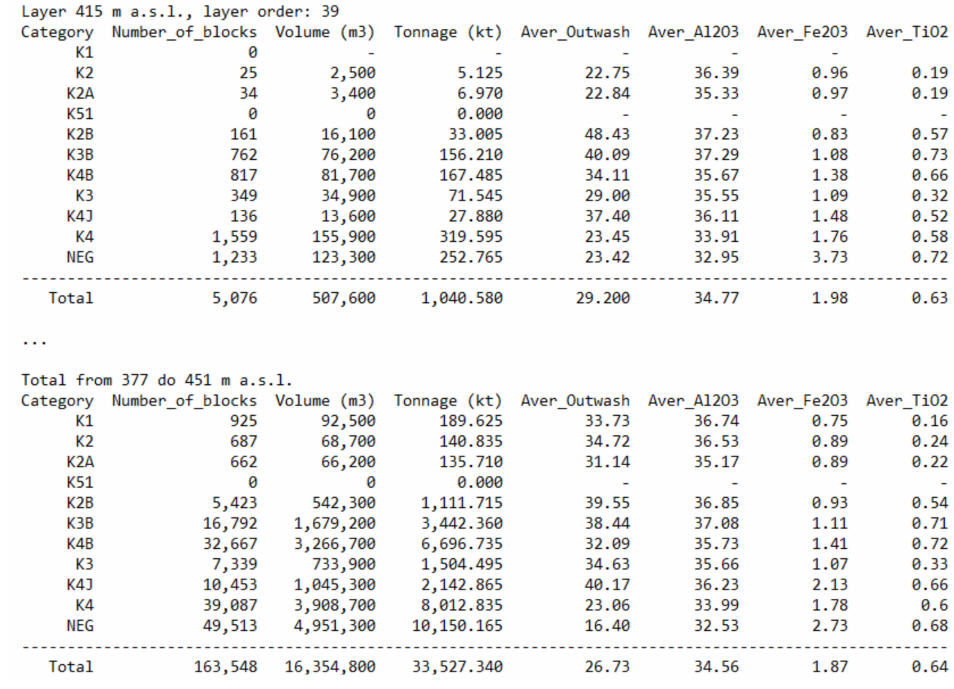
Figure 18. Sample part of the resulting stock of the